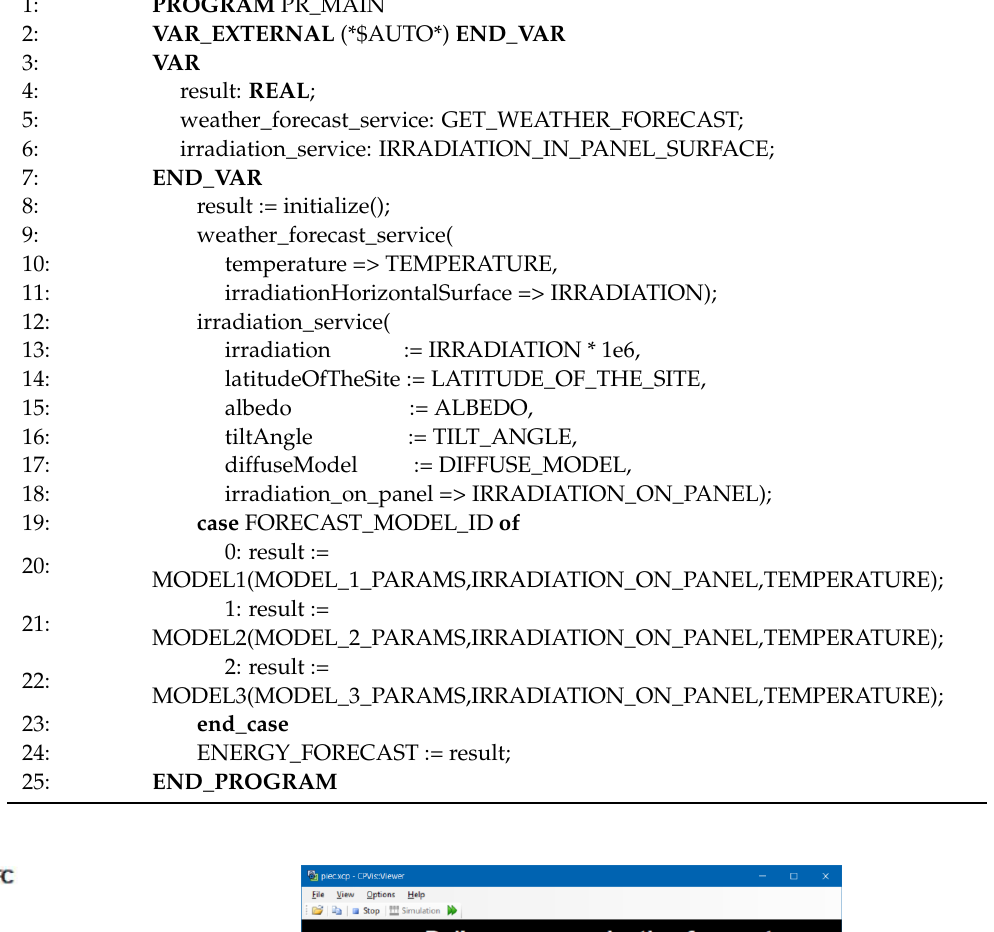
Algorithm 2 The main function of the energy production forecast program.